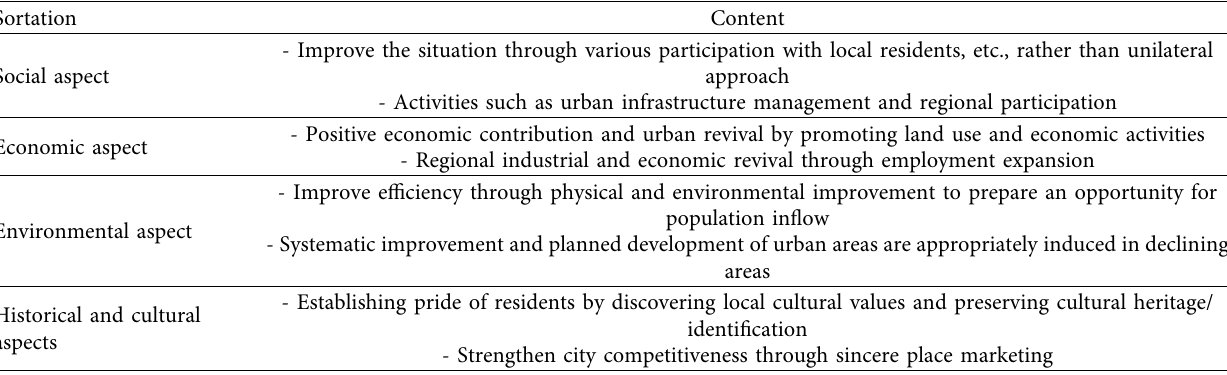
Table 1: Categories of urban